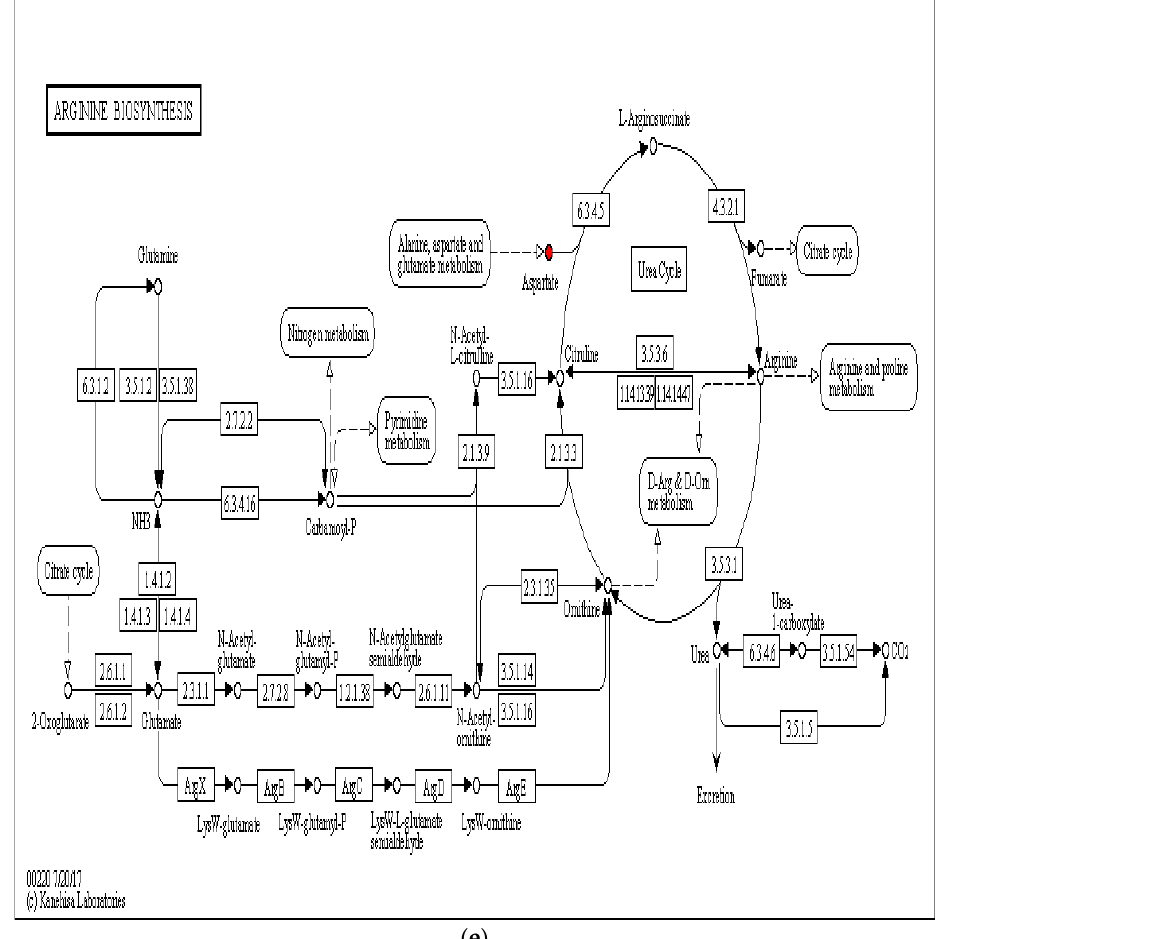
Figure 8. Significant enrichment KEGG pathway (( a ) synthesis and degradation of ketone bodies; ( b ) glycine, serine and threonine metabolism; ( c ) lysine degra ‐ dation; ( d ) vitamin B6 metabolism; ( e ) arginine biosynthesis).